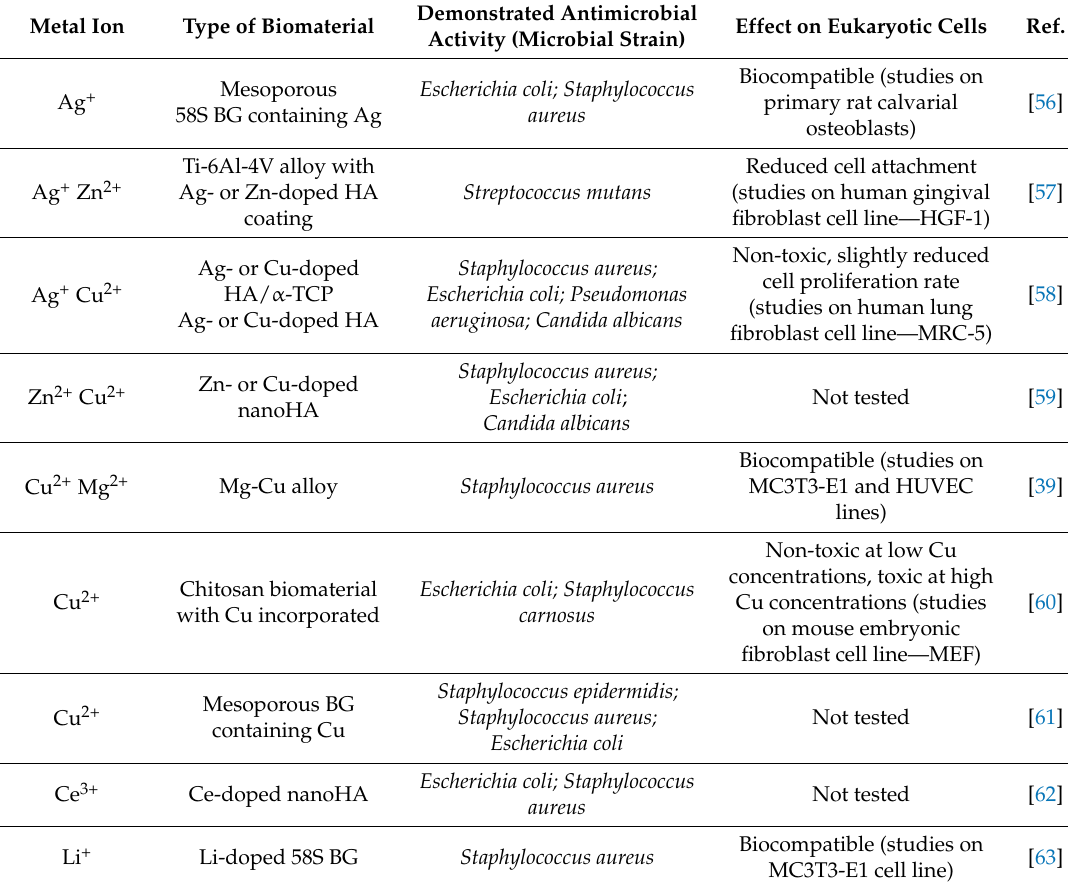
Table 2. Examples of antimicrobial biomaterials produced by modification with metal